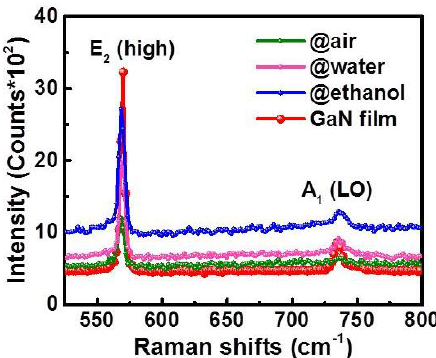
Figure 3. The Raman spectra of GaN-NPs@air, GaN-NPs@water, GaN-NPs@ethanol and GaN Figure 3 . The Raman spectra of GaN-NPs@air, GaN-NPs@water, GaN-NPs@ethanol and GaN film.